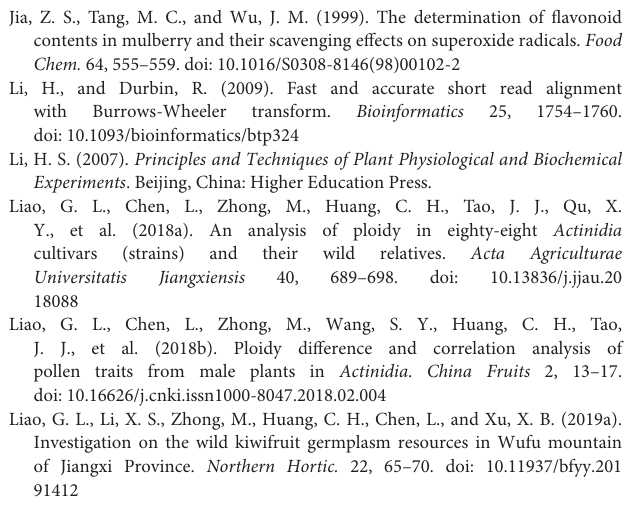
Supplementary Material 3 | Significant SNP of 11 quantitative traits under different association models. Supplementary Material 4 | SNP and candidate genes significantly associated with flower and leaf